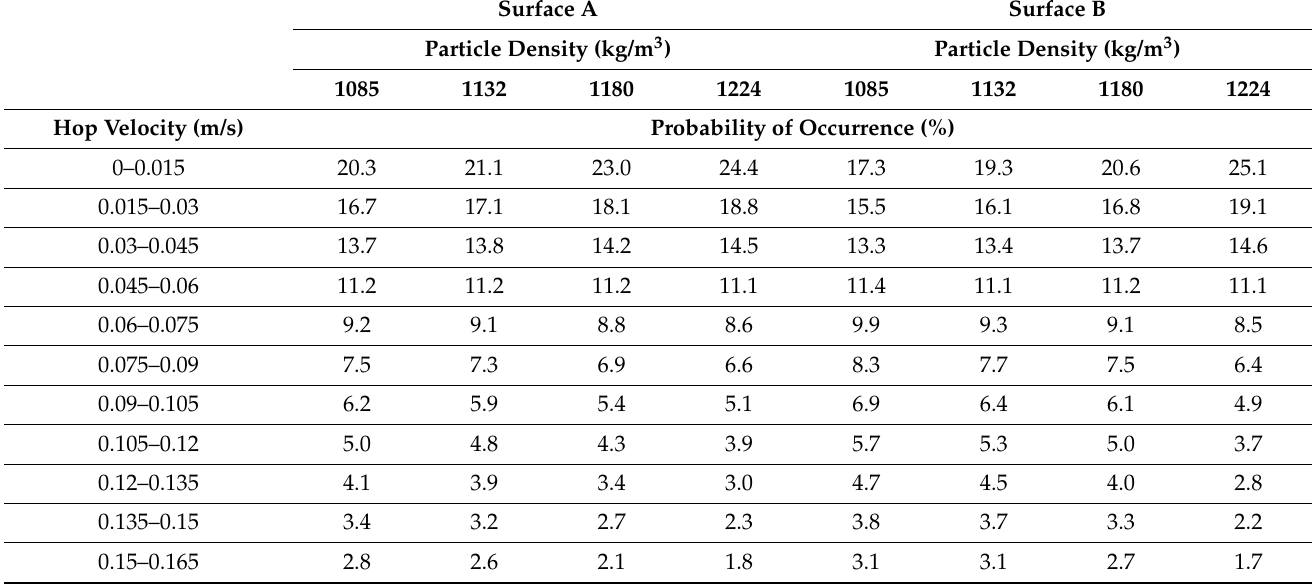
Table A5. The effect of different particle densities on the particle velocity exponential distribution model parameters, for bed surface A (and Reynolds number of 50,789), and bed surface B (and Reynolds number of 51,488). These tabulated data correspond to the results plotted in Figure